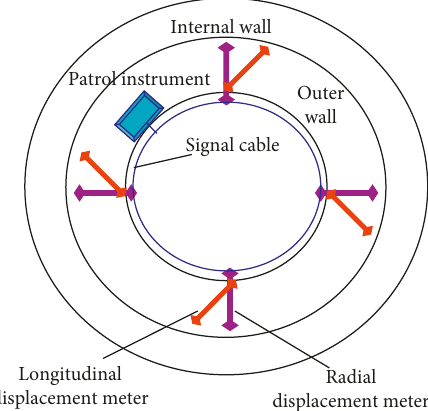
Figure 6: Layout of test components.